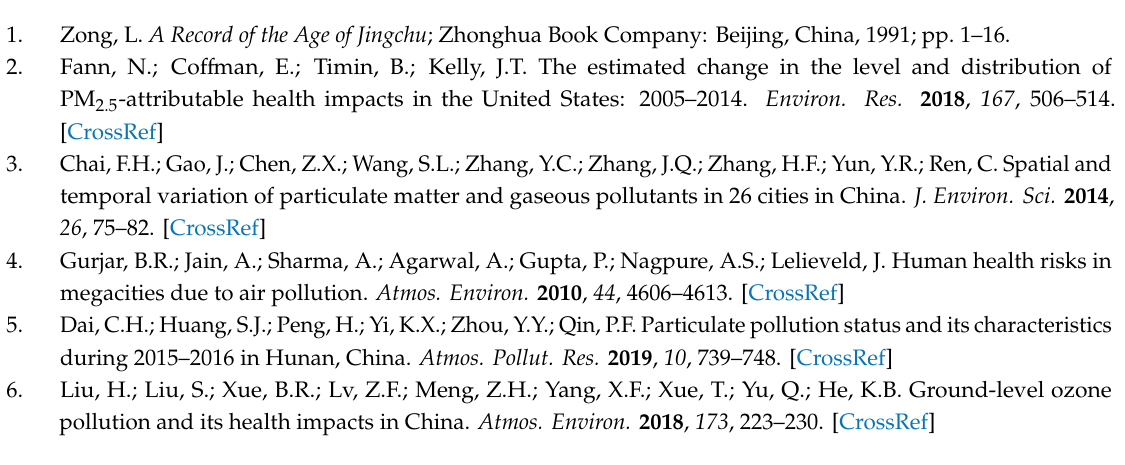
Figure S1. Scheme of important timing during the Chinese Lunar New Year celebration period; Figure S2. Distribution of PM 2.5 monitoring stations in mainland China by the end of 2016; Figure S3. National hourly PM 2.5 concentration during New Year’s Eve and the next two days; Table S1. Meteorological data information; Table S2. Chinese New Year dates in 2002–2016; Table S3. Dates of important days during 2013–2016 Chinese Lunar New Year celebration periods; Table S4. Tibetan New Year date and its firework display time; Table S5. Classification results of PM 2.5 response in 31 provincial capitals during 2013–2016 celebration periods; Table S6. The meteorological average values in Wuhan from 2013 to 2016; Table S7. The PM 2.5 concentration di ff erences and meteorological average values in Chengdu from 2013 to 2016; Table S8. Meteorological data of Zhengzhou on New Year’s Eve and the following two days in